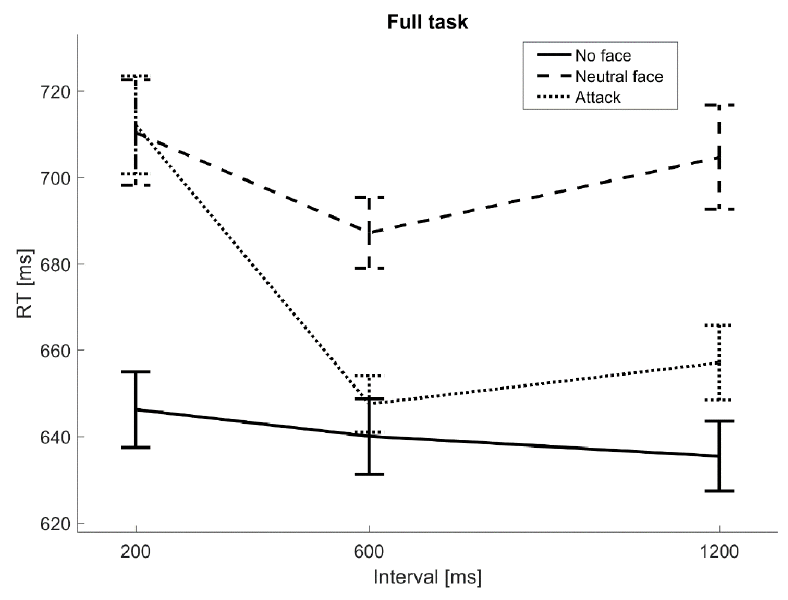
Figure 2b. Reaction times: B. Full task. Note . The figure shows reaction time for the Baseline task (A) and Full task (B). Lines show mean values, and vertical bars show standard errors after correction for between-subject variability (as tests involved within-subject effects). The x-axis shows the interval between the 600 ms timepoint of maintenance period, when attacks could occur, and the presentation of the probe stimulus. In the Baseline task, the presentation of a Neutral face can be seen to cause slower RTs at all intervals. In the Full task, this effect remains. RTs on Attack trials are similar to RTs on Neutral Face trials at the shortest interval, but then strongly decrease, dropping close to the level of trials on which no face was presented as